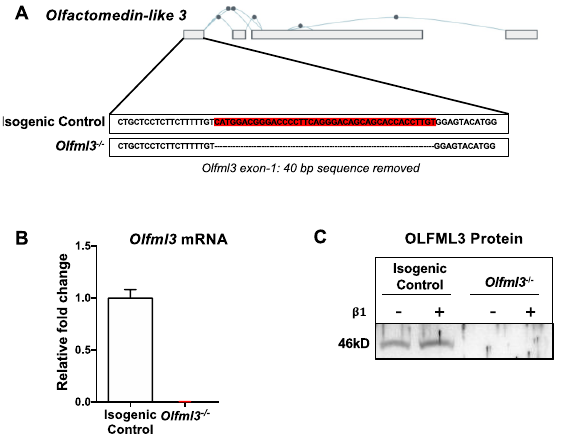
Figure 2. Development and validation of CRISPR-Cas9-mediated Olfml3 gene editing in microglia. ( A ) Depiction of mouse Olfml3 with predicted splice variants, demonstrating targeted deletion of 40 bases within Exon 1. ( B ) Olfml3 mRNA was detected in isogenic control, but not Olfml3 -/- , microglia. ( C ) Representative immunoblot for OLFML3, demonstrating immunoreactivity at the predicted molecular weight (46 kD) in isogenic control, but not Olfml3 -/- , N9 cells. Bars represent group mean with standard error of the mean (SEM); data represent one of three independent experiments. Table 1. Primer and guide-RNA sequences used for PCR and CRISPR-Cas9, respectively. Gene.